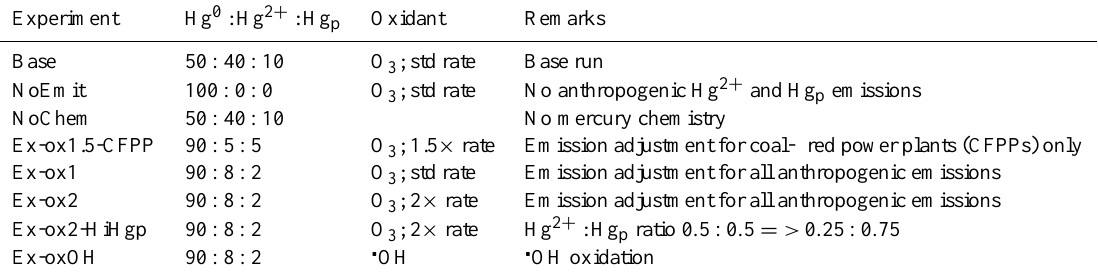
Table 2. Description of model runs and most important parameters that were used in this study. The “base” experiment corresponds to configuration used in L. Zhang et al. (2012).